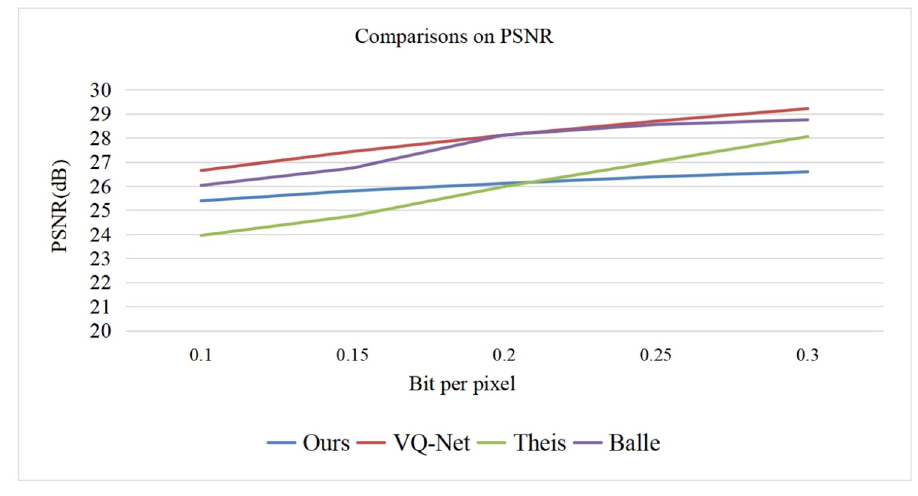
Fig 15. Comparisons on PSNR.